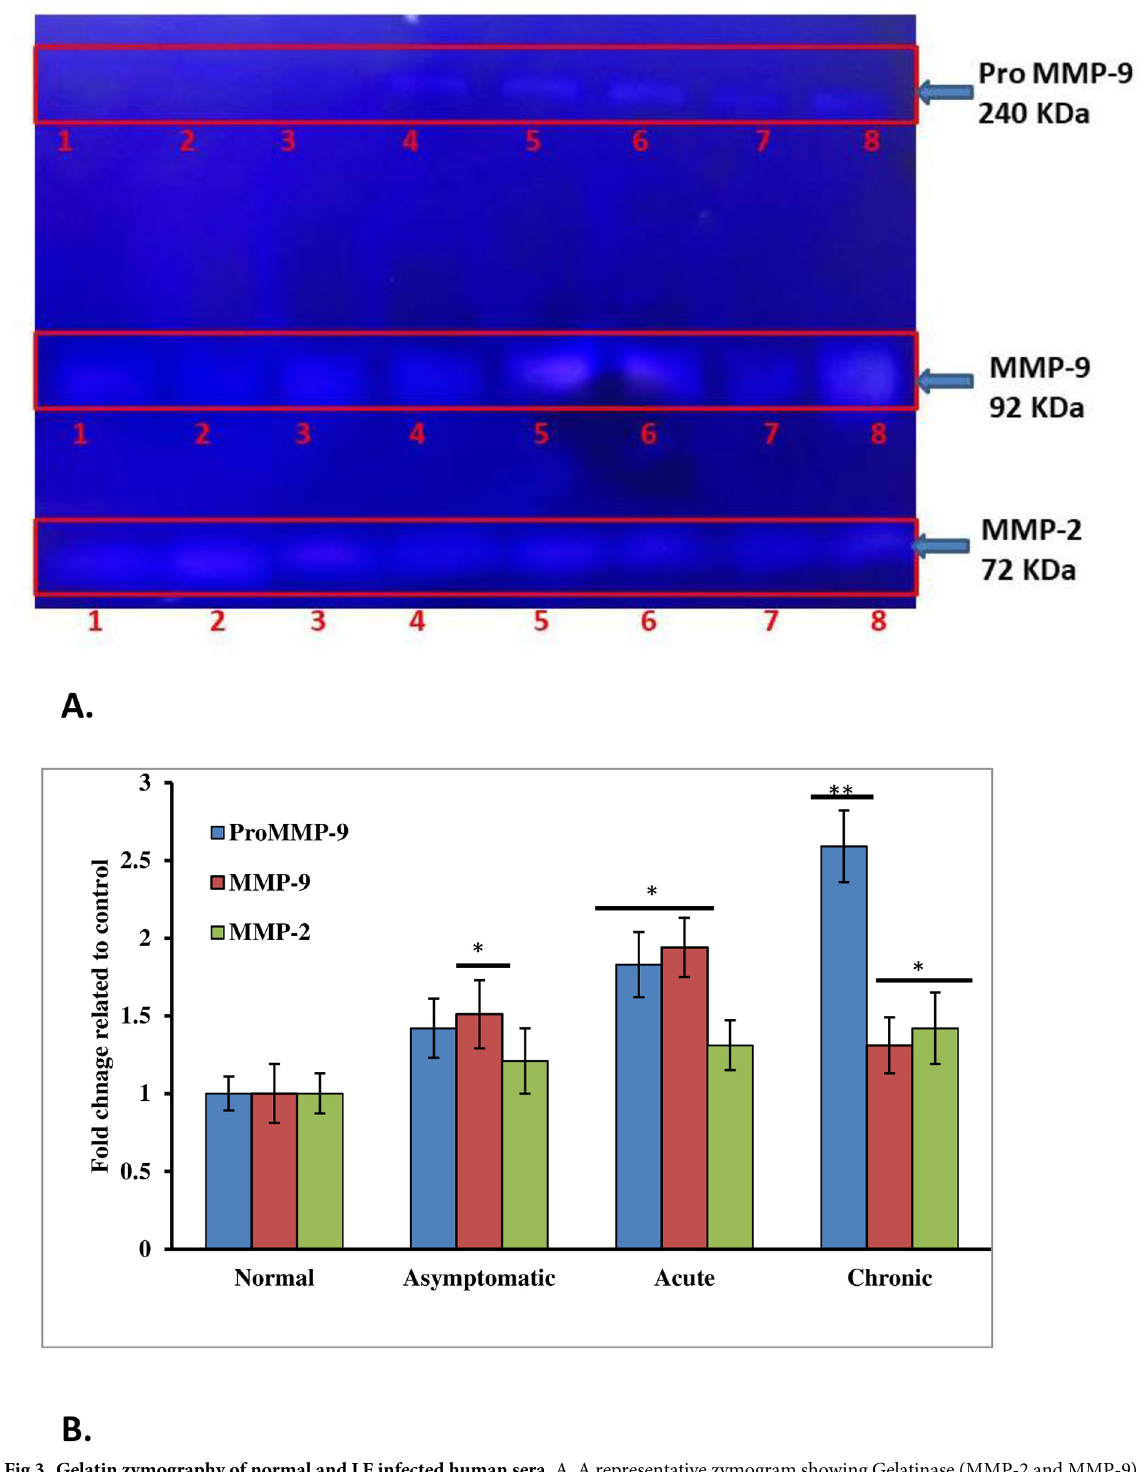
Fig 3. Gelatin zymography of normal and LF infected human sera. A. A representative zymogram showing Gelatinase (MMP-2 and MMP-9) activity of normal and LF infected human sera (Lane 1. Normal-I, 2. Normal-II, 3. Asymptomatic-I, 4. Asymptomatic-II, 5. Acute-I, 6. Acute-II, 7. Chronic-I, 8. Chronic-II). B. A graph showing quantification of ProMMP-9, MMP-9, and MMP-2 by densitometry analysis of zymogram.